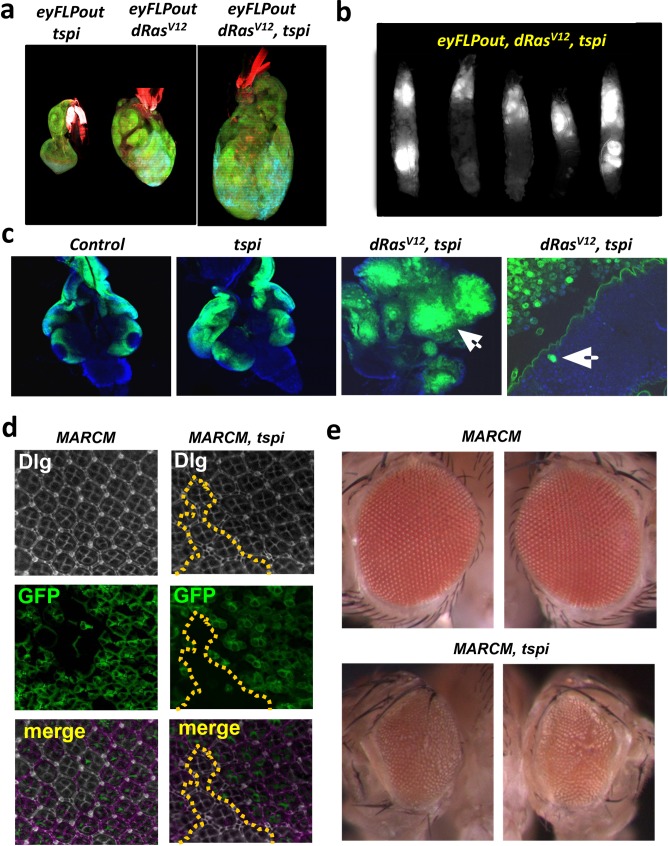
Knockdown of Tsp29Fb affects cell morphology and cooperates with dRasV12 in tumor growth and invasion.(a) Co-expression of Tsp29FbRNAi (tspi) with dRasV12 using the ey-FLP-out system results in neoplastic transformation and overgrowth of larval eye-antenna discs (right), whilst tspi expression shows no overt phenotype (left) and dRasV12 leads to hyperplastic larval discs without interfering with pupariation. Magnifications 20X. GFP (green) shows the ey-FLP-out tissue. The tissue is stained with Phallodin-TRITC (red) to detect F-actin. (b)
tspi dRasV12 third instar larvae exhibit massive overgrowth and giant tumors. Magnifications 4X. (c)
ey-FLP-out tspi, dRasV12 and tspi dRasV12 third instar larval eye discs propagated at 29°C, showing that tspi dRasV12 GFP+ cells have migrated into the VNC. Arrows show tissue disorganisation and tumor fusion to optic lobes (far right) with ventral nerve cord invasion (second from the right). (d) Pupal eye discs containing MARCM control or tspi clones (bottom, marked by the presence of GFP, and the clonal boundary is outlined by a yellow dotted line). Dlg is downregulated and mislocalized from the apical cortex upon Tsp29Fb knockdown. (e) Control MARCM adult eyes and tspi MARCM adult eyes. Tsp29Fb knockdown in clones results in a small rough eye phenotype.